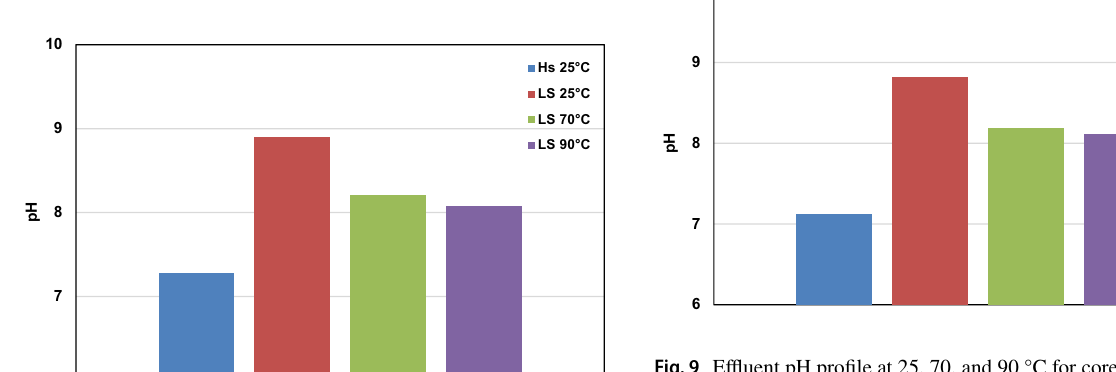
Fig. 9 Effluent pH profile at 25, 70, and 90 °C for